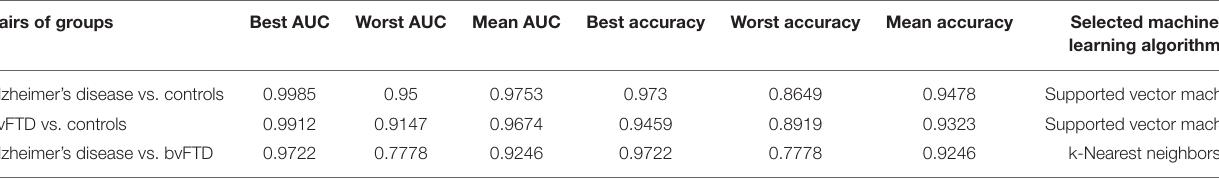
learning algorithm